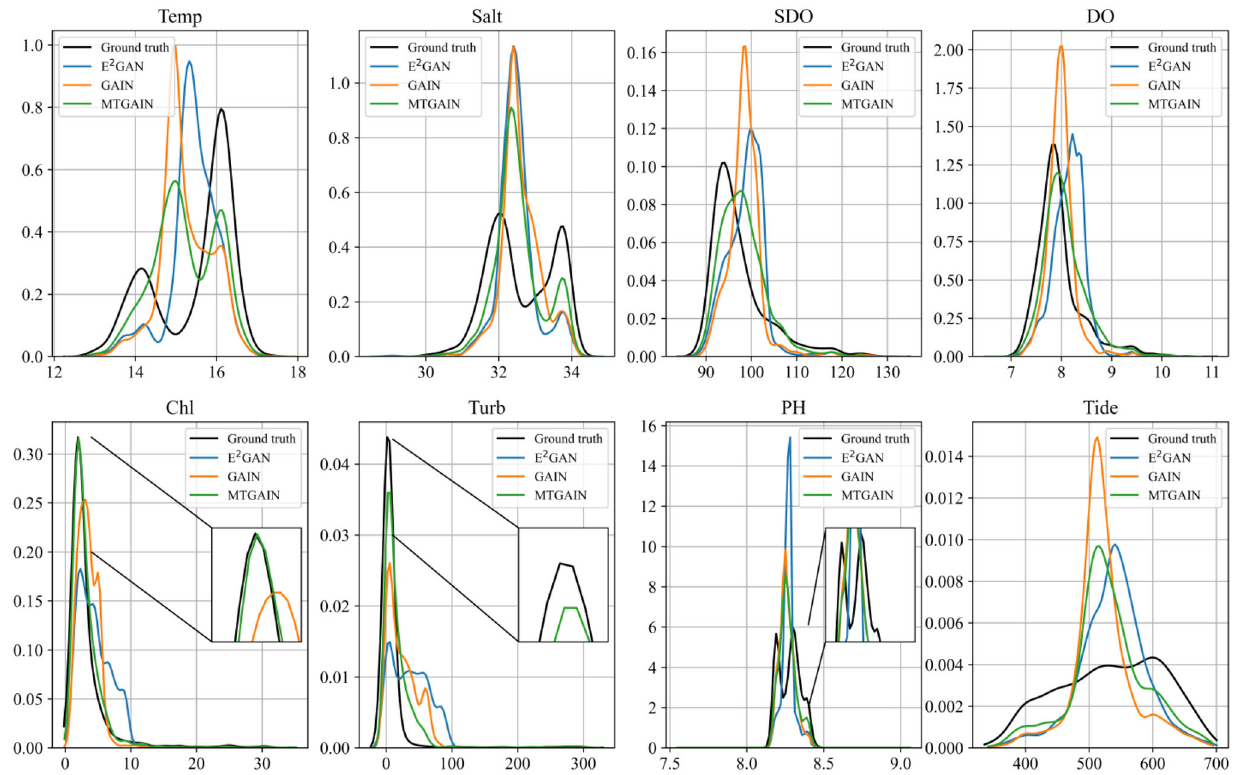
Fig. 4 The distributions of different attributions reconstructed by different methods under 70% missing rate